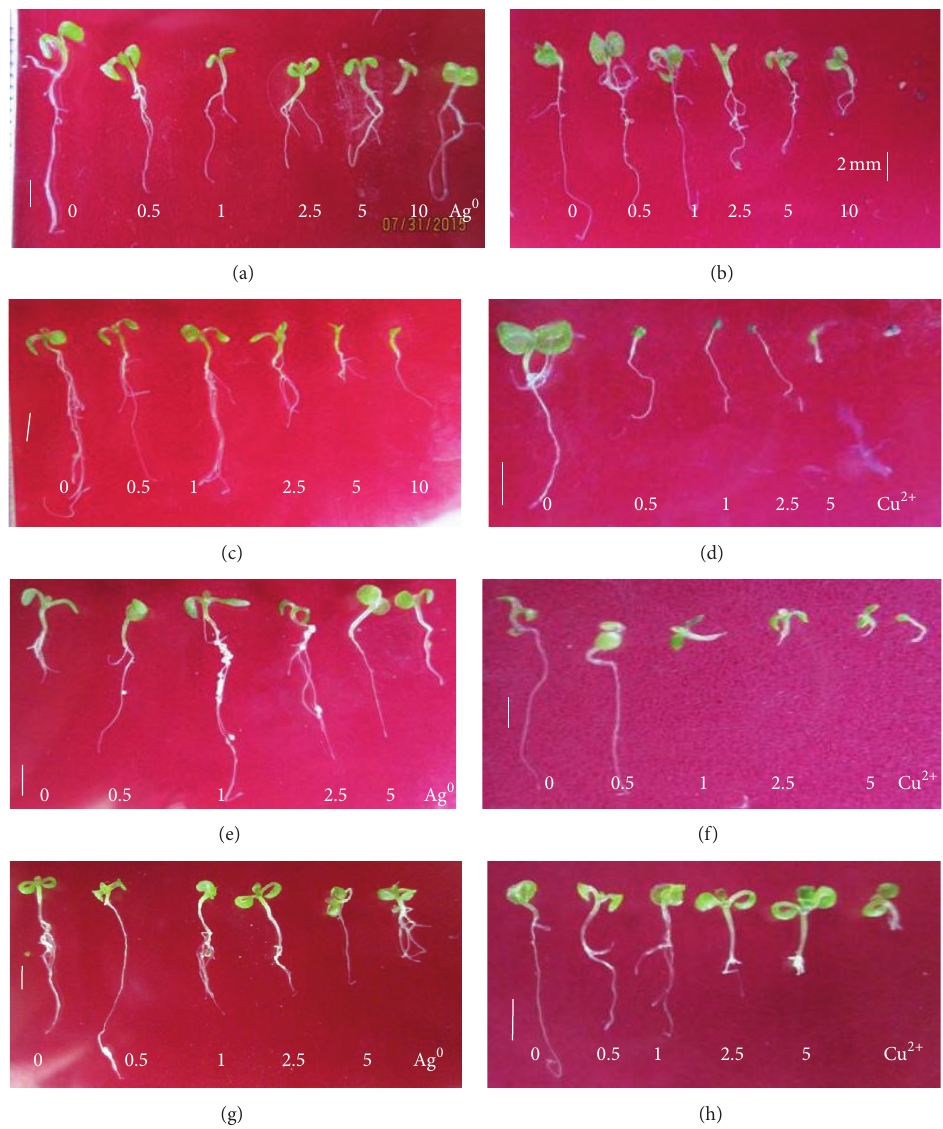
Figure 5: Seedlings of A. thaliana exposed to NSMs. (a) Ag@TiO 2 and (b) TiO 2 -Cu 2+ in MS broth medium for a week; (c) Ag@TiO 2 and (d) TiO 2 -Cu 2+ in H 2 O for a week; (e) Ag@TiO 2 and (f) TiO 2 -Cu 2+ in H 2 O, radiated for 24h; (g) Ag@TiO 2 and (h) TiO 2 -Cu 2+ in H 2 O, nonradiated for 24 h. Numbers indicate NSMs concentrations (0, 0.5 1, 2.5, 5, and